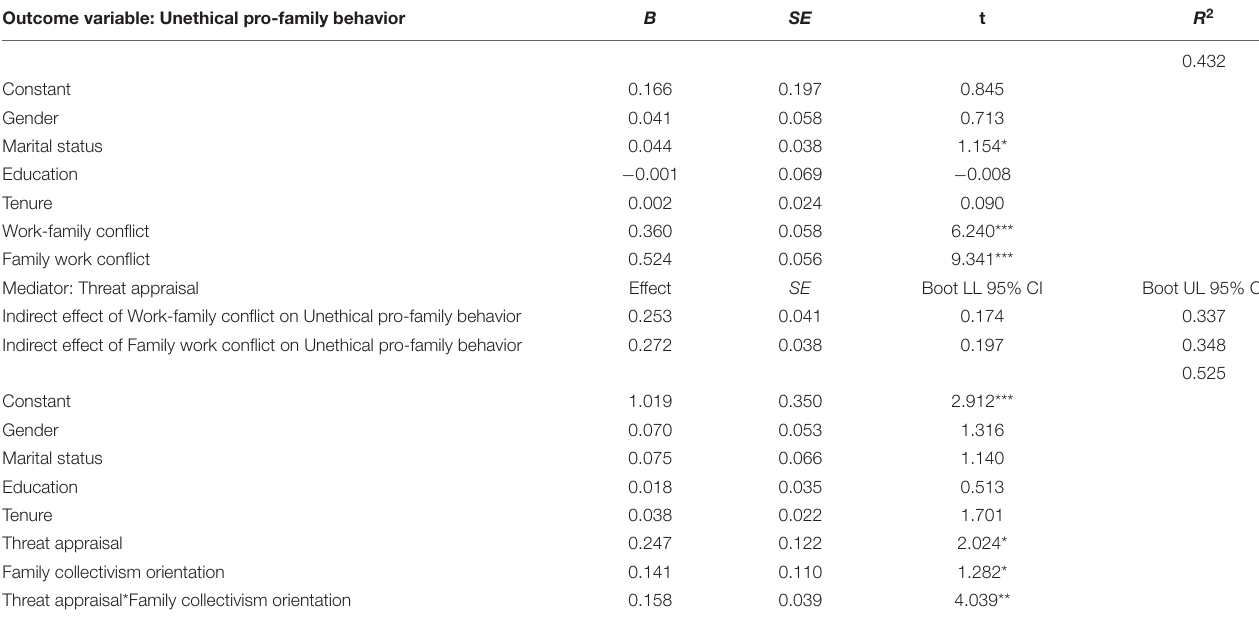
TABLE 3 | Regression results of mediating and moderating effects.